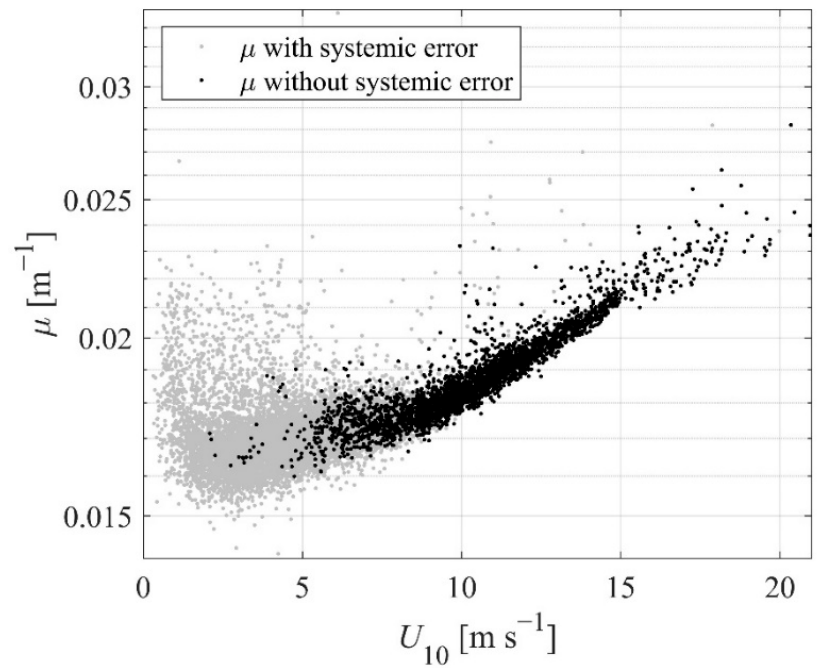
. Grey dots are the laser intensity attenuation (cid:2869)(cid:2868)